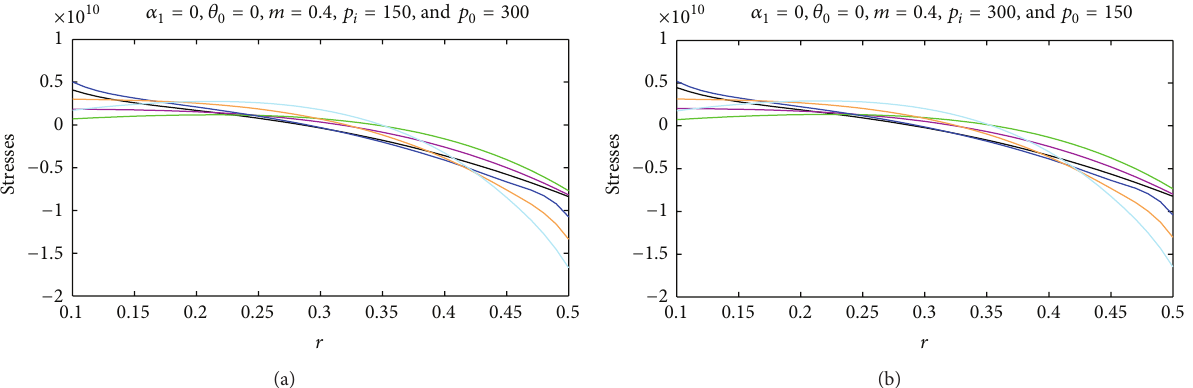
Figure 5: Elastic-plastic stresses in a rotating cylinder with variable thickness and variable density without thermal effects ( 𝜃 0 = 0 ) with parameters 𝑒 1 = 0, 1, 2 and strain hardening measure 𝑚 = 0.4 under internal and external pressure.